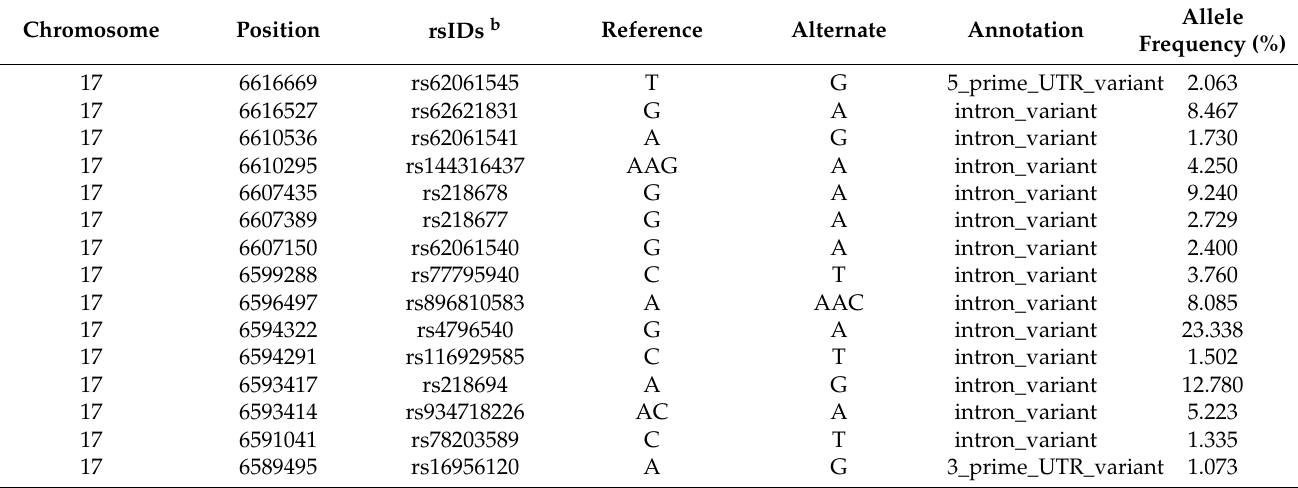
Table 1. The variants of the SLC13A5 gene in the non-coding region (allele frequency > 1%) a .